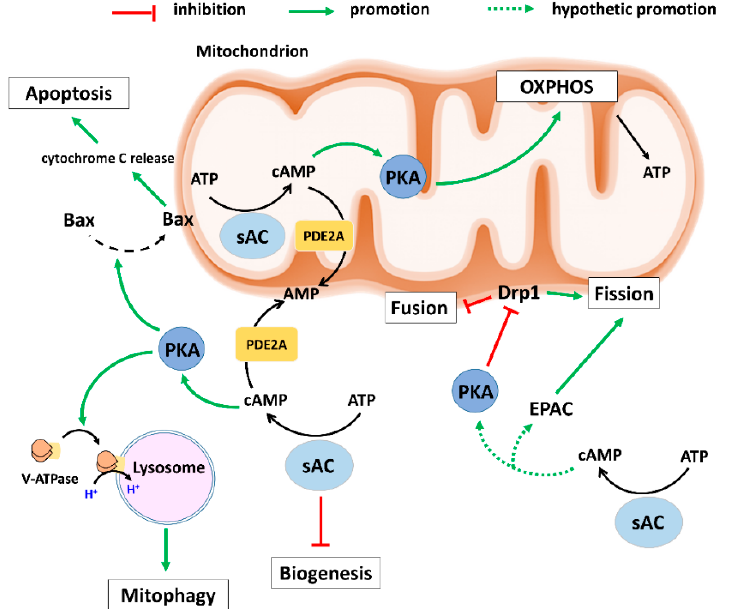
Figure 1. Schematic presentation of the effects of sAC-signalling on mitochondrial biology. Intramitochondrial sAC-signalling activates OXPHOS leading to ATP production. Under various stresses, extramitochondrial sAC–PKA axis promotes the recruitment of pro-apoptotic Bax to mito- chondria and induces cytochrome c release leading to apoptosis. Furthermore, extramitochondrial sAC–PKA axis supports the removal of defective mitochondria (Mitophagy) by inducing recruitment of V-ATPase to lysosomes. Moreover, extramitochondrial sAC-signalling inhibits mitochondrial biogenesis via a still unknown mechanism. The extramitochondrial PKA and EPAC regulate mi- tochondrial dynamics and may be activated by the sAC-derived cAMP pool. AMP: Adenosine monophosphate; ATP: Adenosine 5 (cid:48) -triphosphate; cAMP: cyclic AMP; EPAC: Exchange protein directly activated by cAMP; Drp1: Dynamin-related protein 1; OXPHOS: oxidative phosphorylation; PDE2A: Phosphodiesterase 2A; PKA: Protein kinase A; sAC: soluble adenylyl cyclase; V-ATPase: